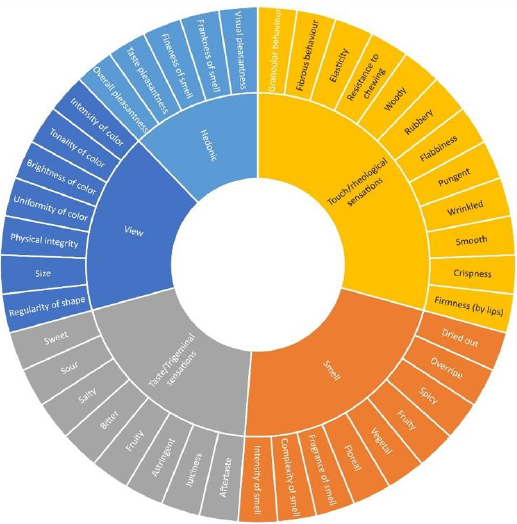
Figure 1. Sensory wheel of flower analysis (XLSTAT ver. 2019.4.1) .